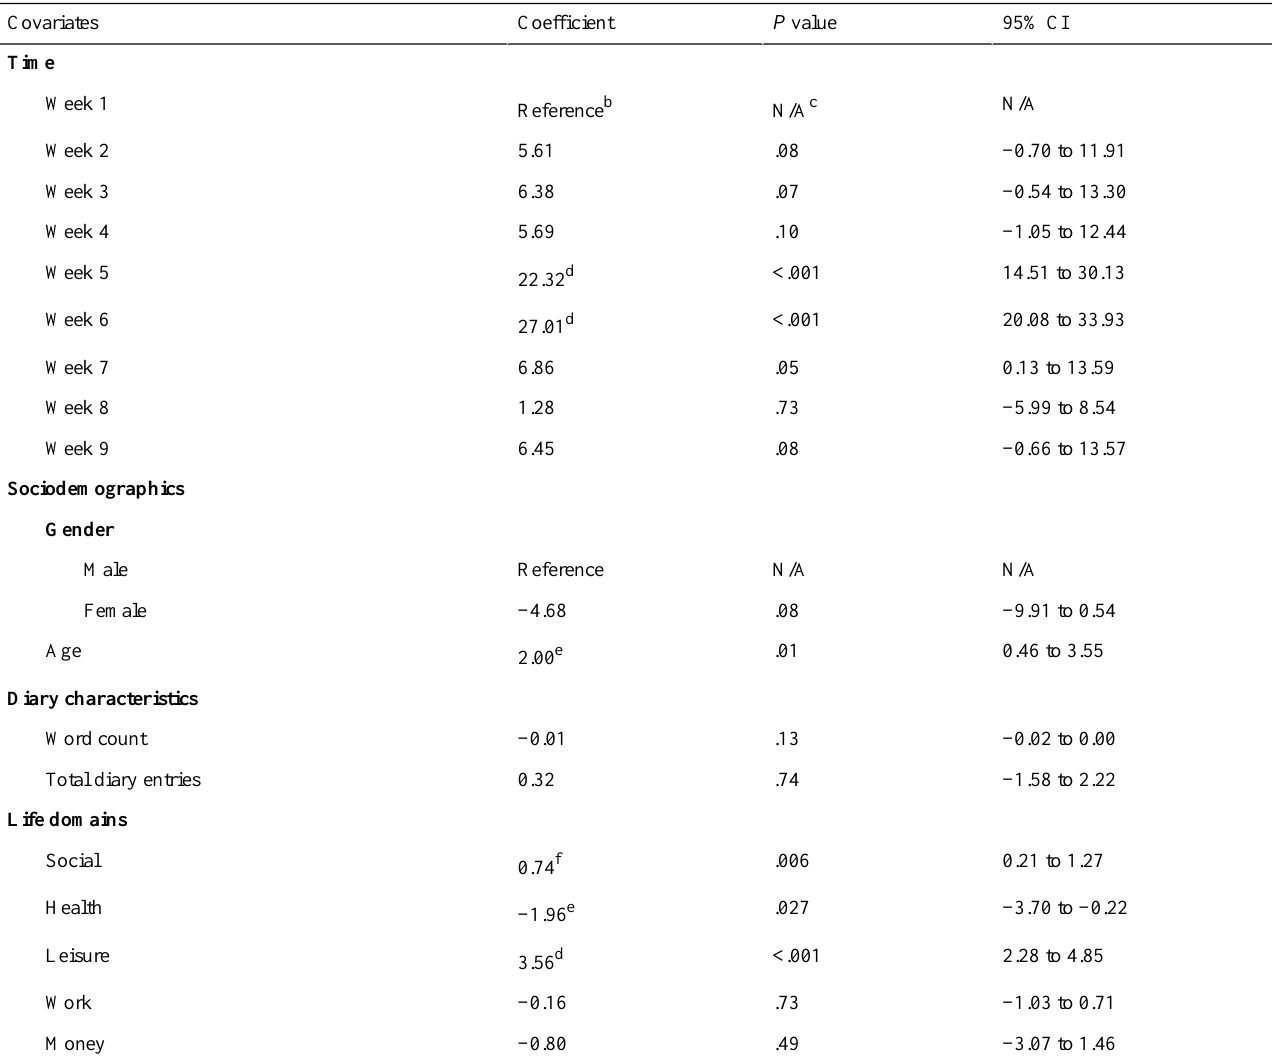
Table 6. Model 3: random effects generalized least squares regression examining how the use of words from 5 life domains (social, health, leisure, work, and money) relates to the emotional tone of diary entries, controlling for week effects (time), sociodemographics (age and gender), and diary characteristics.